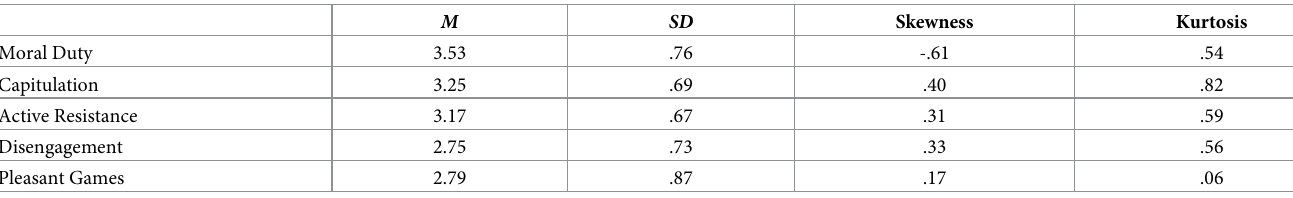
Table 3. Descriptive statistics for the questionnaire’s